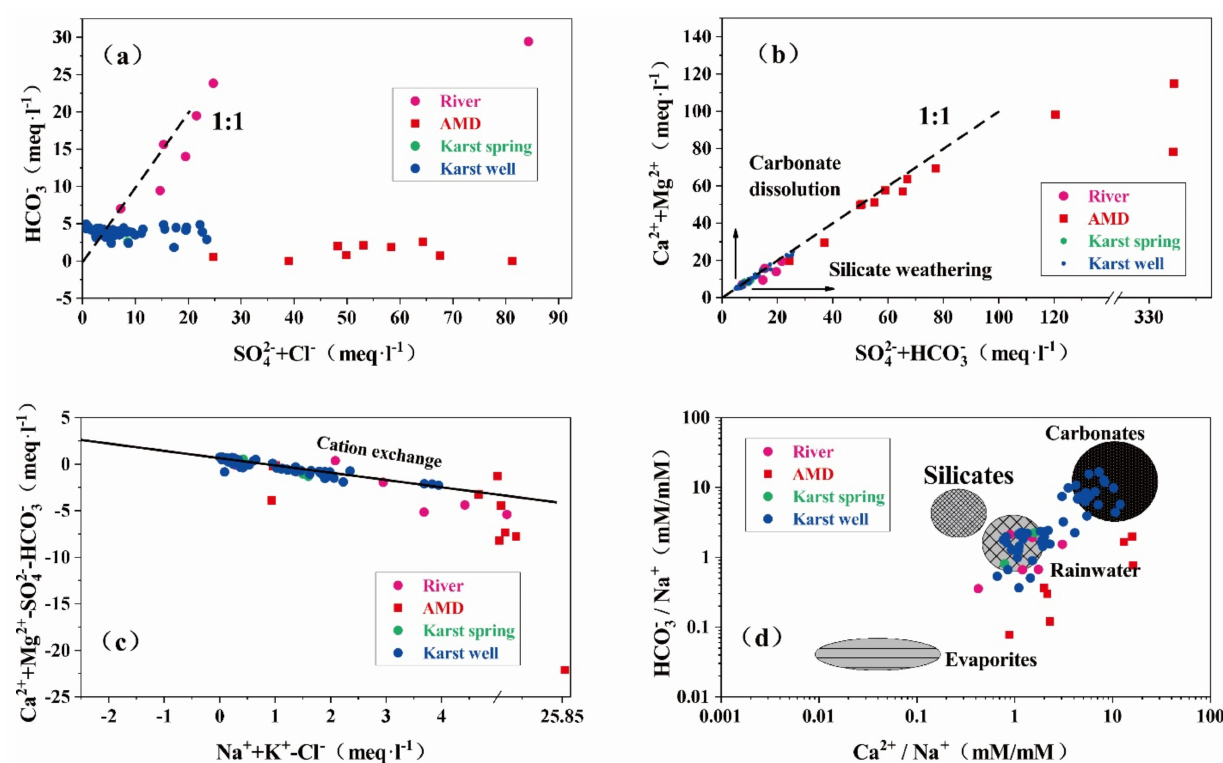
Figure 12. Ion relationship involving karst groundwater in the Niangziguan Spring Catchment ( a ) Relationships between Mg 2+ vs. SO 42 − , ( b ) SO 42 − +HCO 3 − vs. Ca 2+ +Mg 2+ , ( c ) Na + +K + -Cl − vs. Ca 2+ +Mg 2+ -SO 42+ -CO 3 − , ( d ) Ca 2+ /Na + vs. HCO 3 − /Na + .